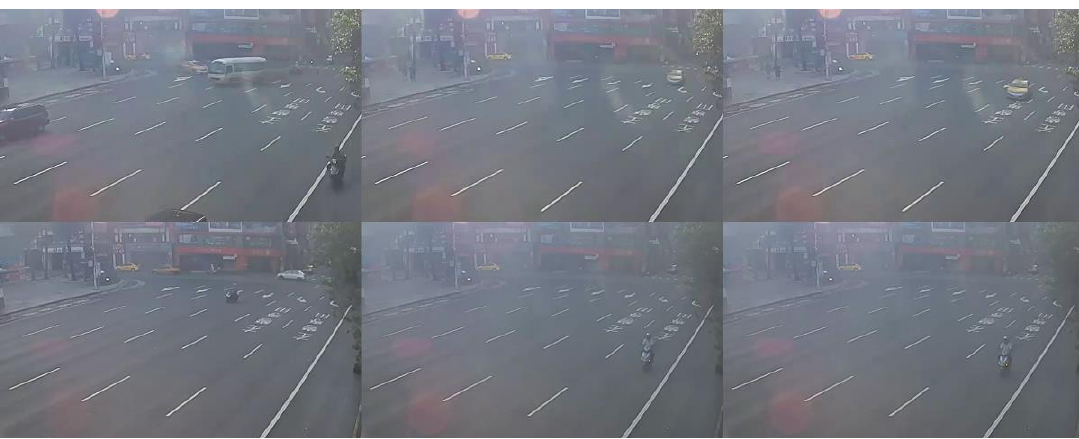
Figure 4. Collected sample images of the partitions affected by sunset.